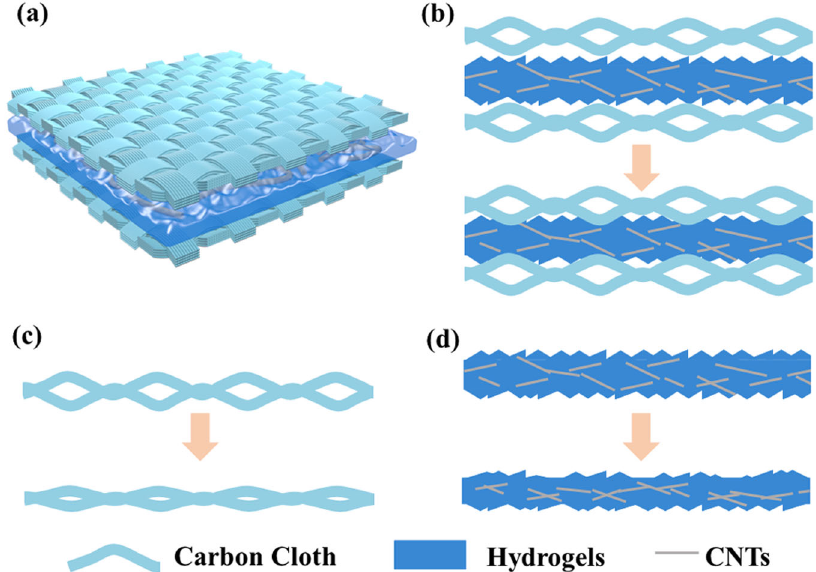
Fig. 3 Schematic description of sensing mechanism. a Schematic diagram of the structure of the sensor with LBG/PVA/CNTs-DR hydrogels and ( b – d ) its mechanism analysis of the pressing